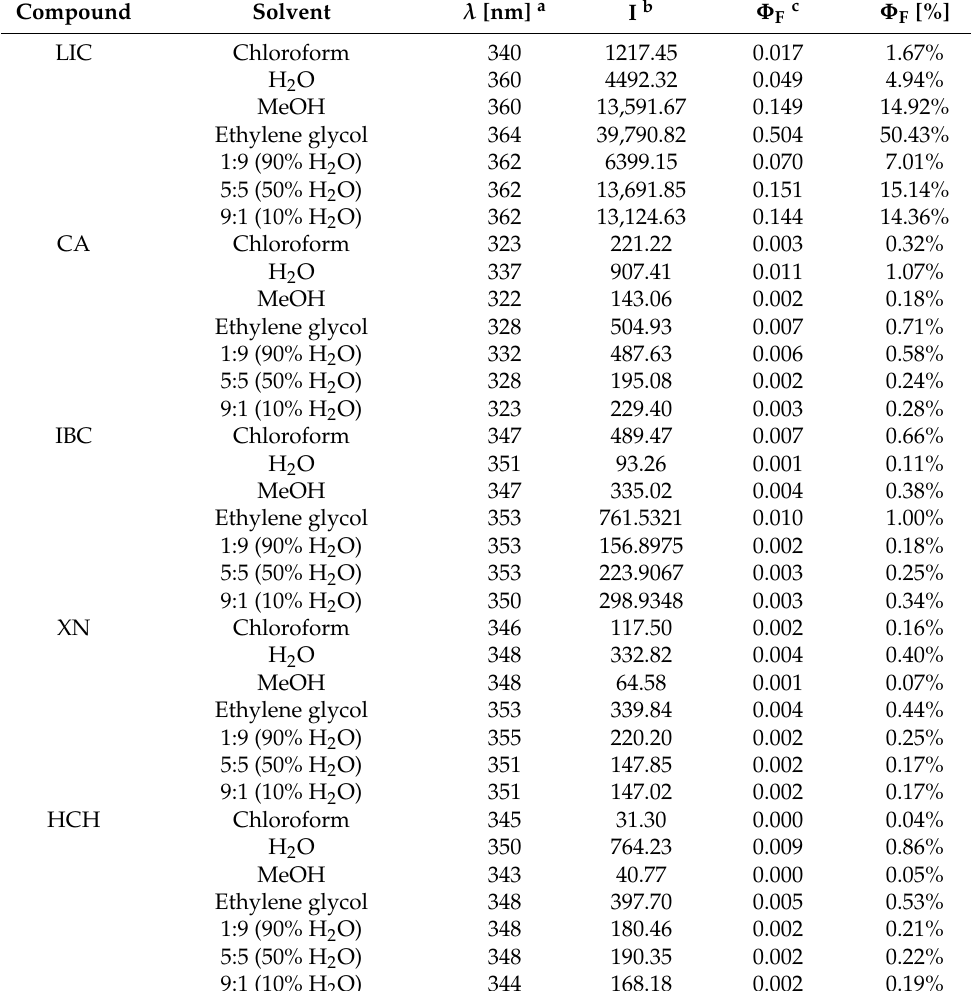
Table 1. Photophysical properties of chalcones: CA, IBC, XN, LIC and HCH (1 µ M) in different solvents and MeOH:H 2 O